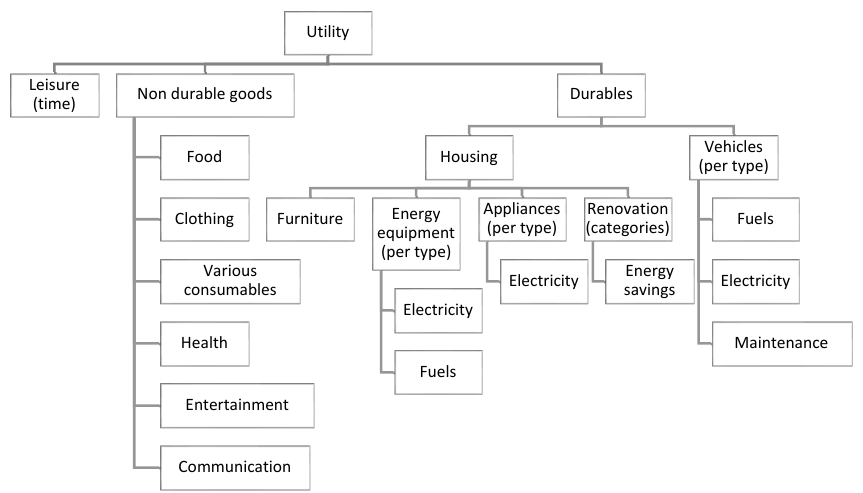
Figure 2. Schematic representation of the GEM-E3-R nesting scheme for private consumption.